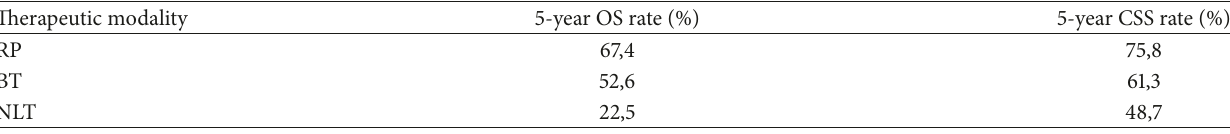
Table 3: Overall survival and disease-specific survival by age and therapeutic modality, adapted from Culp et al. (2014) [13]. Age/therapeutic modality 5-year OS rate (%)